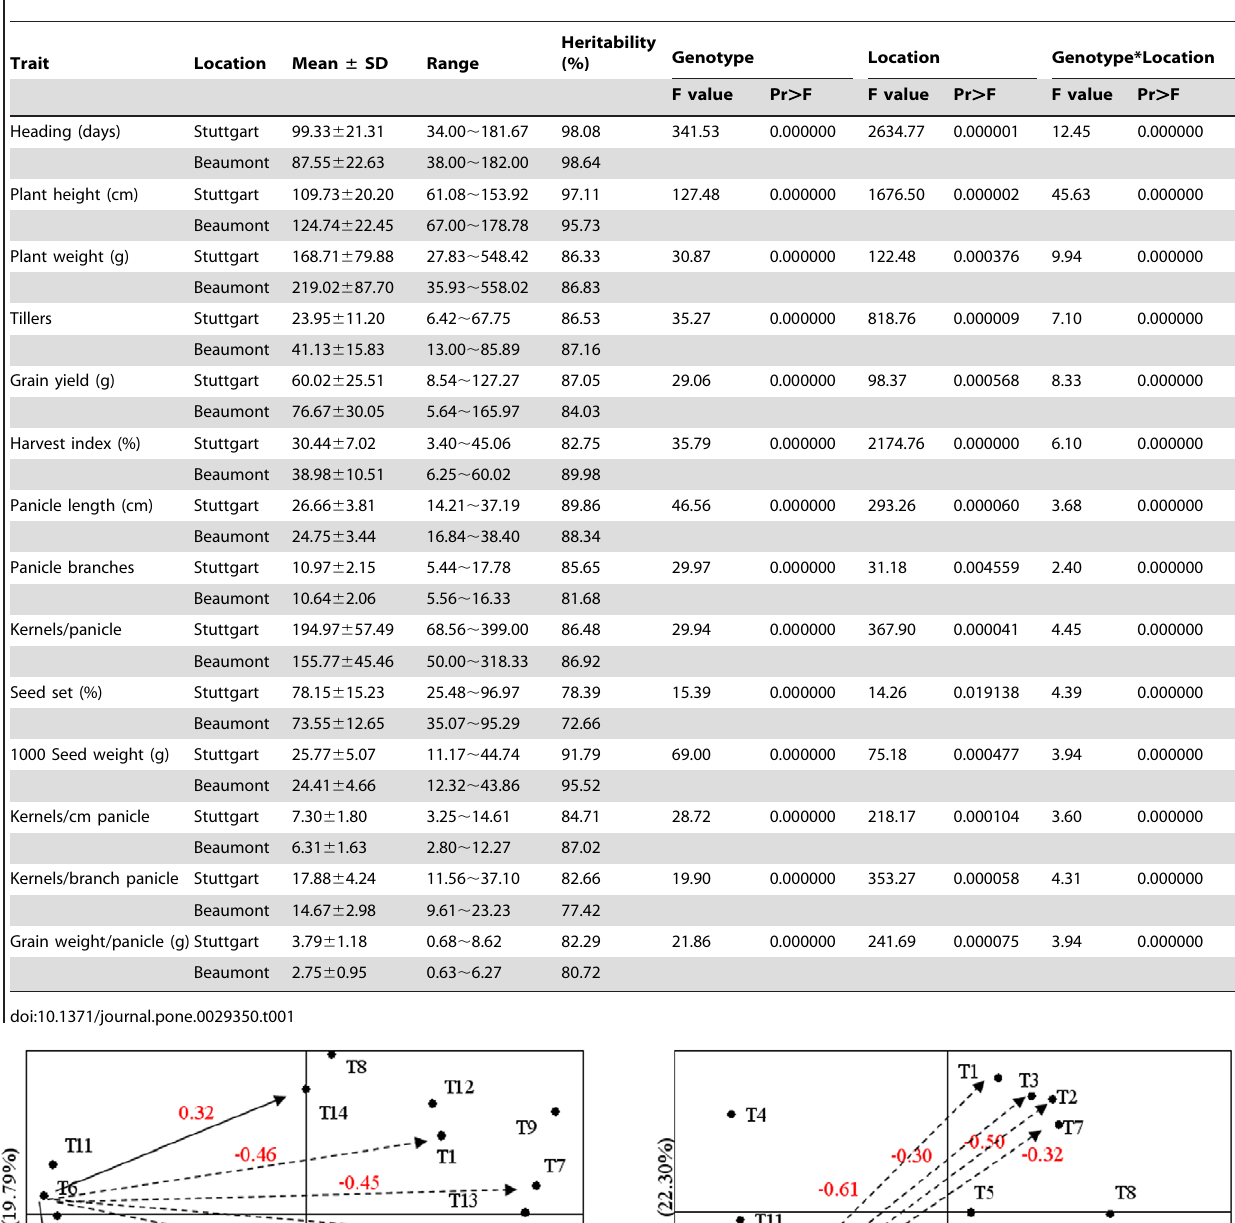
Table 1. Statistical analysis of 14 traits generated at Stuttgart, Arkansas and Beaumont, Texas in 2009 in the USDA rice mini-core collection.